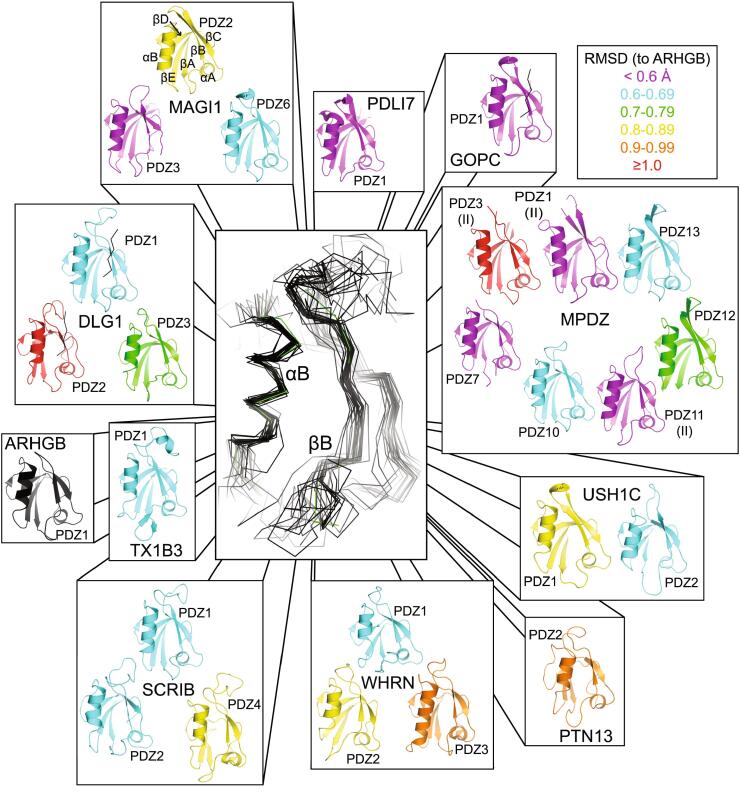
Conservation of the PDZ domain fold. Of the 20 PDZ domain-containing proteins in Fig. 2, 11 have associated structures, which include a total of 26 PDZ domains. We aligned the βB strand and αB helix of each to our reference structure, ARHGB PDZ (PDB ID: 2DLS), with RMSD values ranging from 0.39 Å (MPDZ-1; 2O2T) to 1.37 (MPDZ-3; 2IWN), and an average of 0.72 Å. The central box shows an alignment of all 26 peptide-binding clefts, represented by Cα traces. The individual PDZ domain structures are clustered by parent protein in the boxes surrounding the center alignment, and are colored based on RMSD to the peptide-binding cleft of ARHGB PDZ (see key). Most of the PDZ domains are classified as canonical Class I PDZ domains, with the exceptions of MPDZ PDZ1, 3, and 11, as labeled in brackets underneath the domain name. Binding classification does not seem to determine overall fold, as both MPDZ PDZ1 and 11 show minimal differences to ARHGB PDZ (RMSD < 0.6 Å). The conserved secondary structure elements are labeled in the top left box, on the MAGI1-2 structure. PDB IDs are: 1PDR, 1UEZ, 1UF1, 1UFX, 1UJU, 1WHA, 1X5N, 2DLS, 2FCF, 2FNE, 2IWN, 2IWP, 2KPK, 2O2T, 2OPG, 2OQS, 2Q3G, 2QG1, 2R4H, 2W4F, 3BPU, 3DJI, 3KIR, 3PDZ, 3RL7, 4E34.